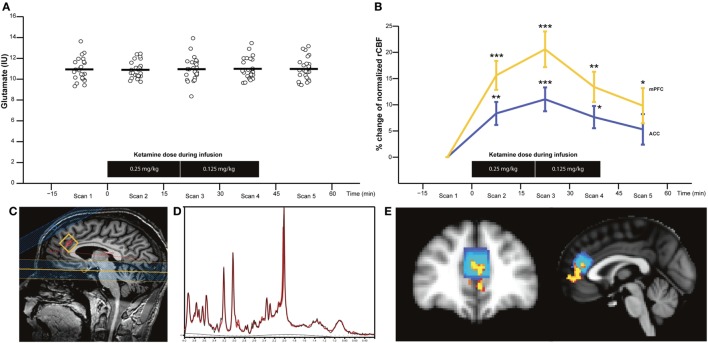
Glutamate levels in anterior cingulate cortex (ACC) (n = 25) (A) and percentage change of normalised resting cerebral blood flow (rCBF) in ACC and medial prefrontal cortex (mPFC) (n = 16) (B) before (scan 1), during (scans 2–4), and after S-ketamine infusion (scan 5). Sagittal image with proton magnetic resonance spectroscopy voxel location (C), representative spectra with raw data (in black) and fitted data (in red) (D), and image of the overlap between the area with the most significant rCBF increase corresponding to mPFC (in yellow) and the ACC corresponding to the MRS voxel (blue) are shown (E). Horizontal bars represent the mean values. *p < 0.0125, **p < 0.0025, and ***p < 0.00025 (p < 0.05/4 to control for multiple comparisons).